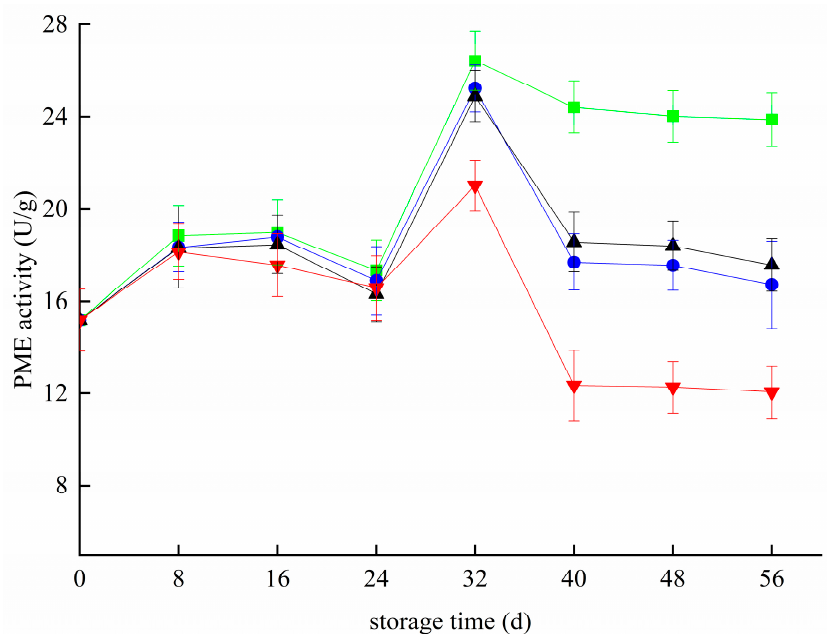
Figure 5. Effect of pectin methylesterase activity in blueberry under different treatments. ■ : control; ● : T; ▲ : Z: ▼ : T plus Z.